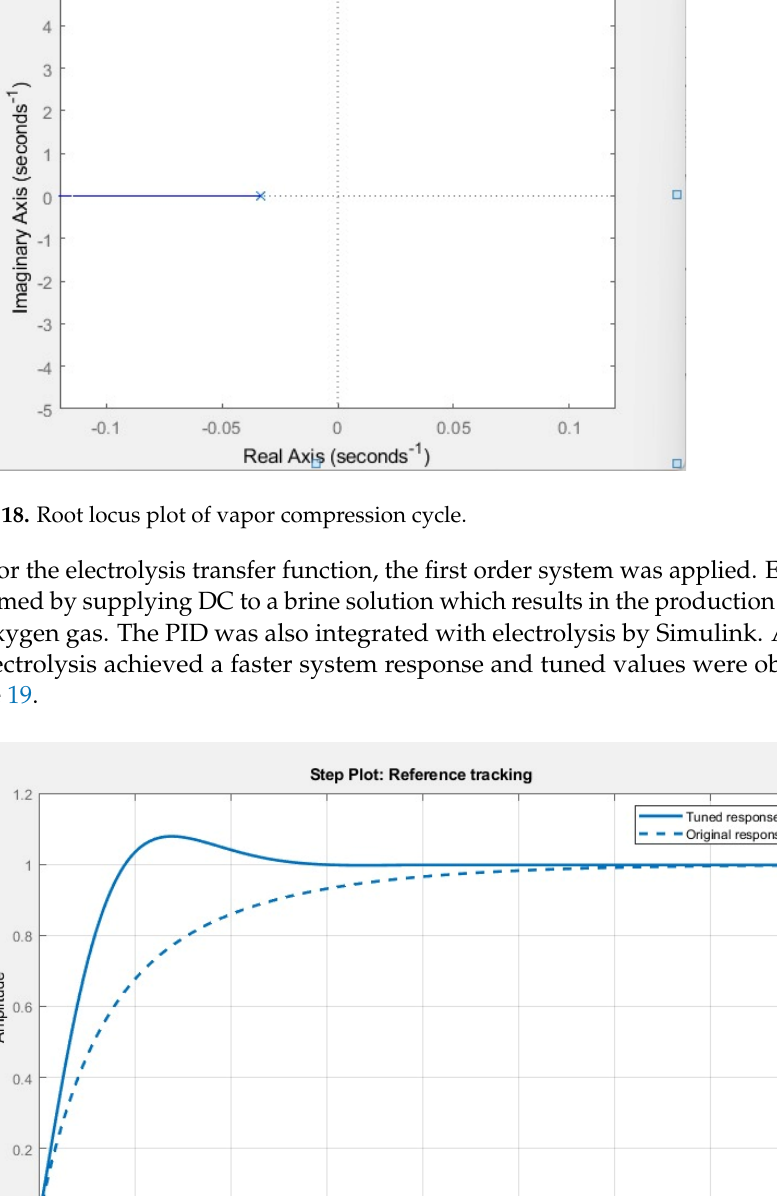
Figure 19. Time response of electrolysis system before tuning and after tuning.